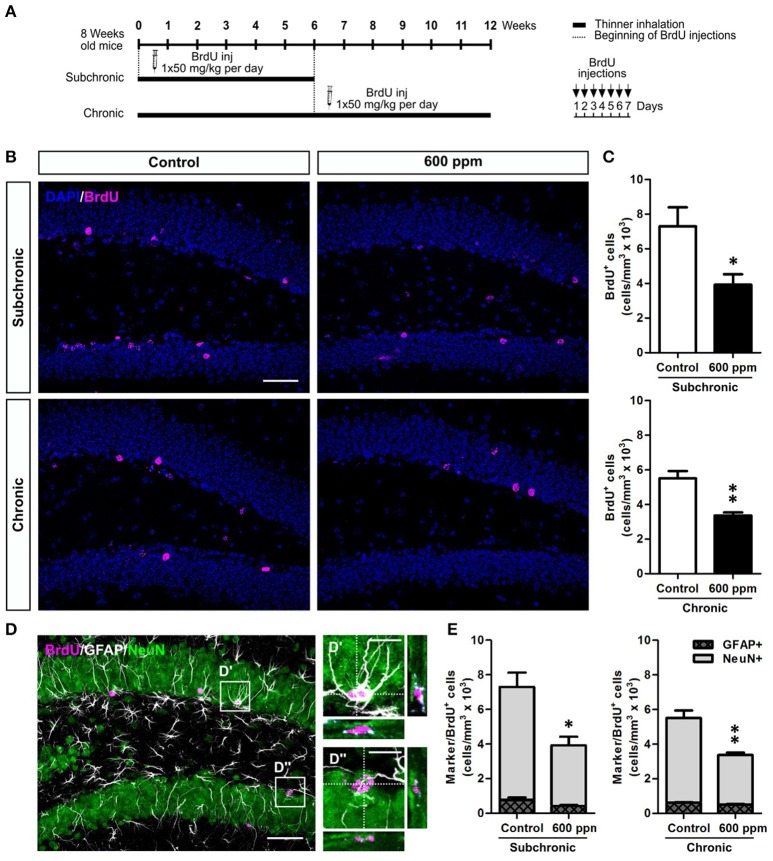
Subchronic and chronic thinner exposures impair survival of DG newborn neurons without altering the balance between neurogenesis and astrogliogenesis in the adult DG. (A) Experimental design: controls and 600 ppm-treated mice received multiple BrdU injections over 1 week, starting from the beginning of the subchronic treatment and on week 6 for the chronic treatment; animals were analyzed at 5 weeks survival post-BrdU injection in both cases. (B) Representative confocal images of the DG stained for BrdU (magenta), with DAPI counterstaining (in blue) in control and 600 ppm-treated mice (subchronic and chronic treatments). (C) BrdU+ cell density in subchronic and chronic groups. (D) Representative confocal image of triple staining for BrdU (magenta), GFAP (white), and NeuN (green). Insets in (D) are displayed at higher magnification with re-slicing in (D',D”), and show a cell double-labeled for BrdU and GFAP (D') and a cell double-labeled for BrdU and NeuN (D”). (E) Cell density of double labeled cells for BrdU/GFAP and BrdU/NeuN among the BrdU+ cell population in subchronic and chronic groups. Error bars indicate SEM (n = 3–4 per group). Student's t-test, *p < 0.05 and **p < 0.01 refer to the control vs. treated groups' comparison. Scale bar: 50 μm in (B,D); 15 μm in insets (D',D”).